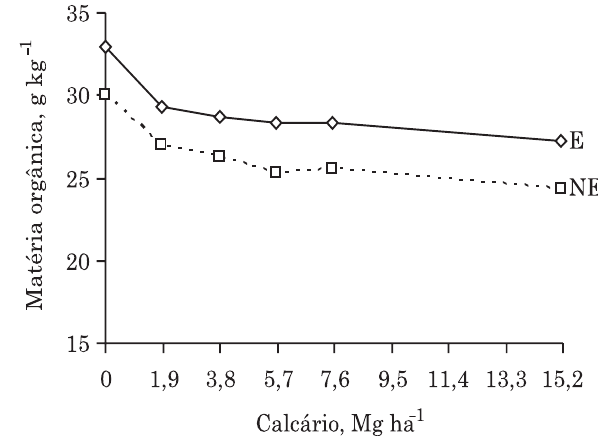
Figura 5. Teor de matéria orgânica do solo, em colunas de solo esterilizadas (E) e não esterilizadas (NE), de acordo com as doses crescentes de calcário.